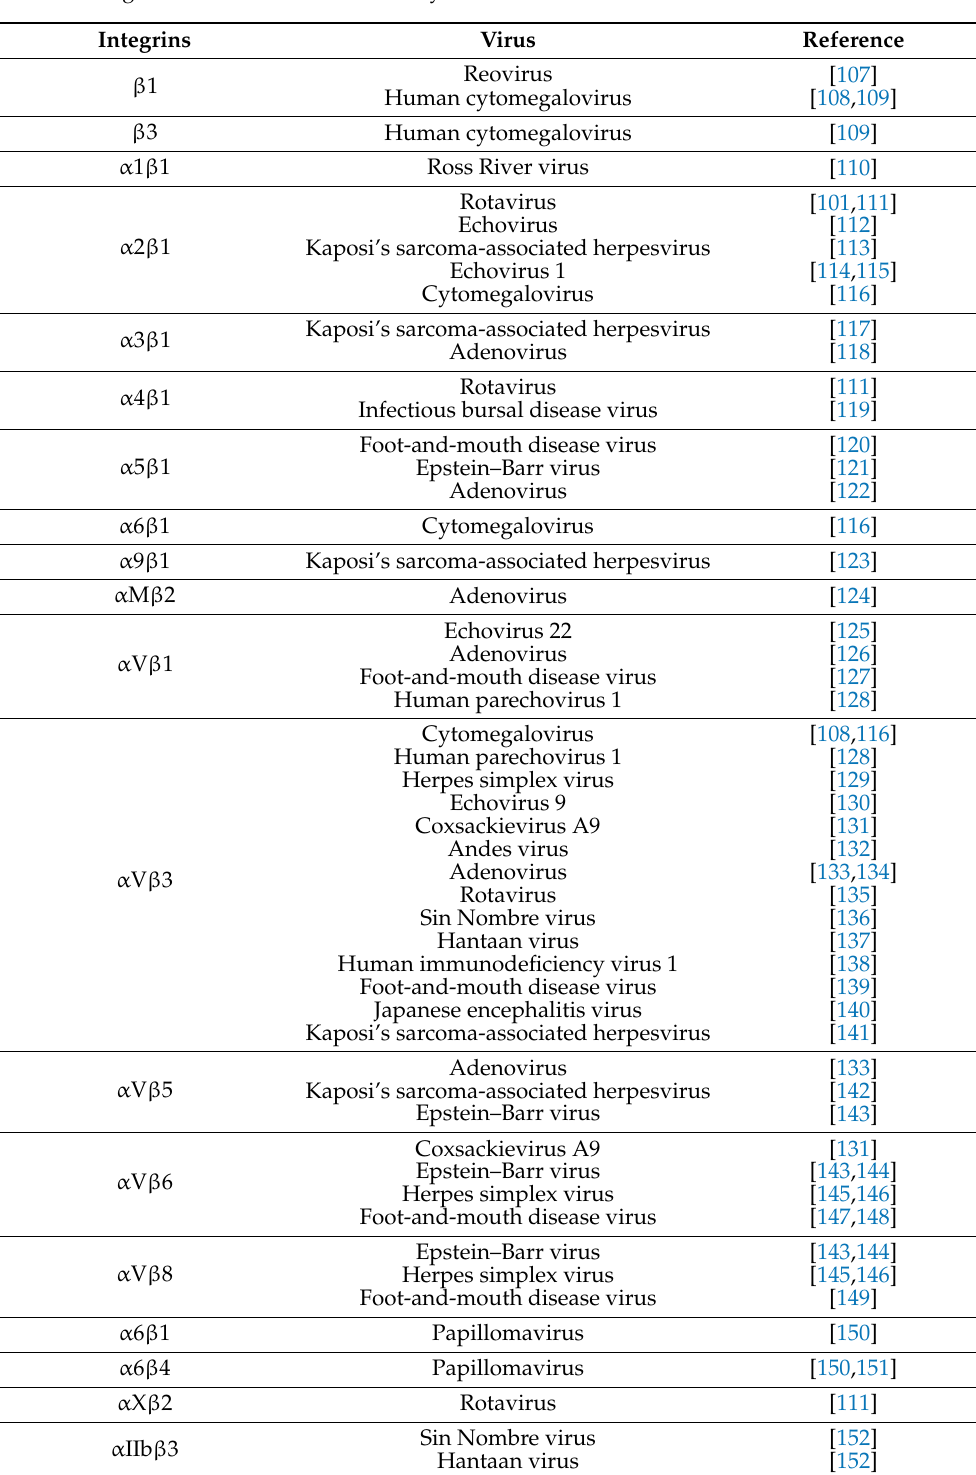
Table 3. Integrins are involved in virus